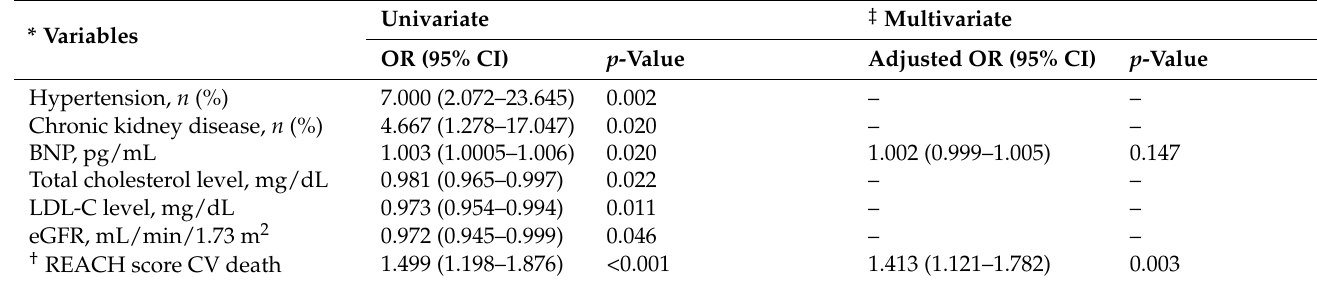
Table 5. Univariate and multivariate logistic regression analysis to evaluate association between high average size of choriocapillaris flow void and baseline characteristics with REACH